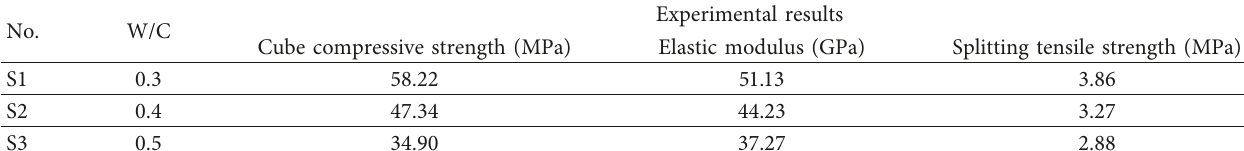
Table 3: Experimental results of mechanical properties of concrete at 28 days.